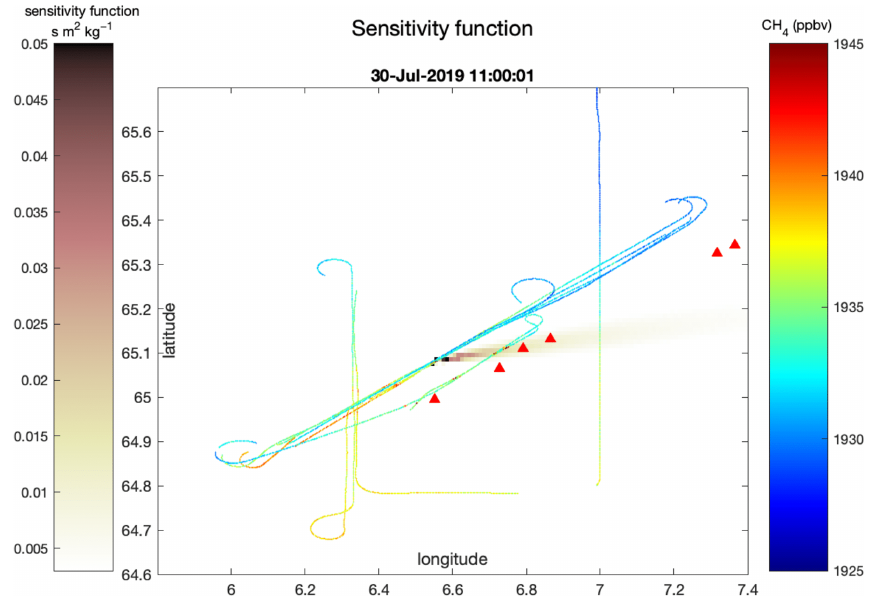
Figure A2. Example snapshot of the calculated FLEXPART footprint for FAAM flight C193 used to aid source identification for measured CH 4 enhancements. The flight track is coloured by the measured CH 4 mixing ratio (right colour bar; ppbv). The shaded area denotes the vertically integrated retroplume (left colour bar; sm 2 kg − 1 ). The red triangles represent the locations of the nearby offshore O&G